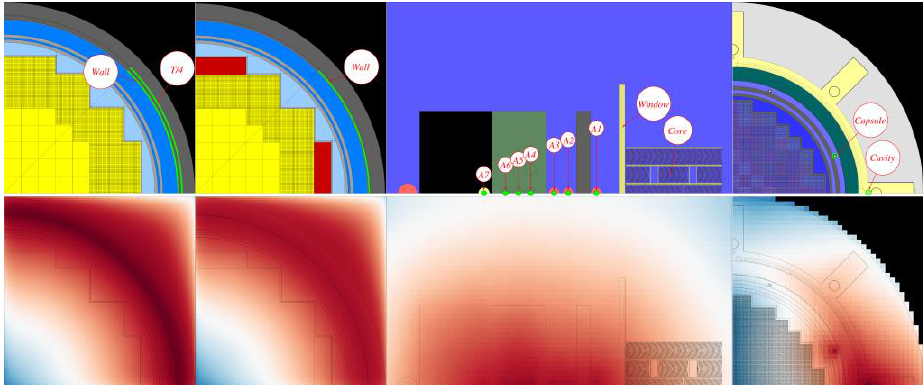
Figure 1 : Top views of the Serpent models used in this work. From left to right: STD; PLS; PCA (partial extents); and HBR-2. Bottom row: detector importance maps. Neutron importance increases from the blue tones toward the red ones. Figures are not to